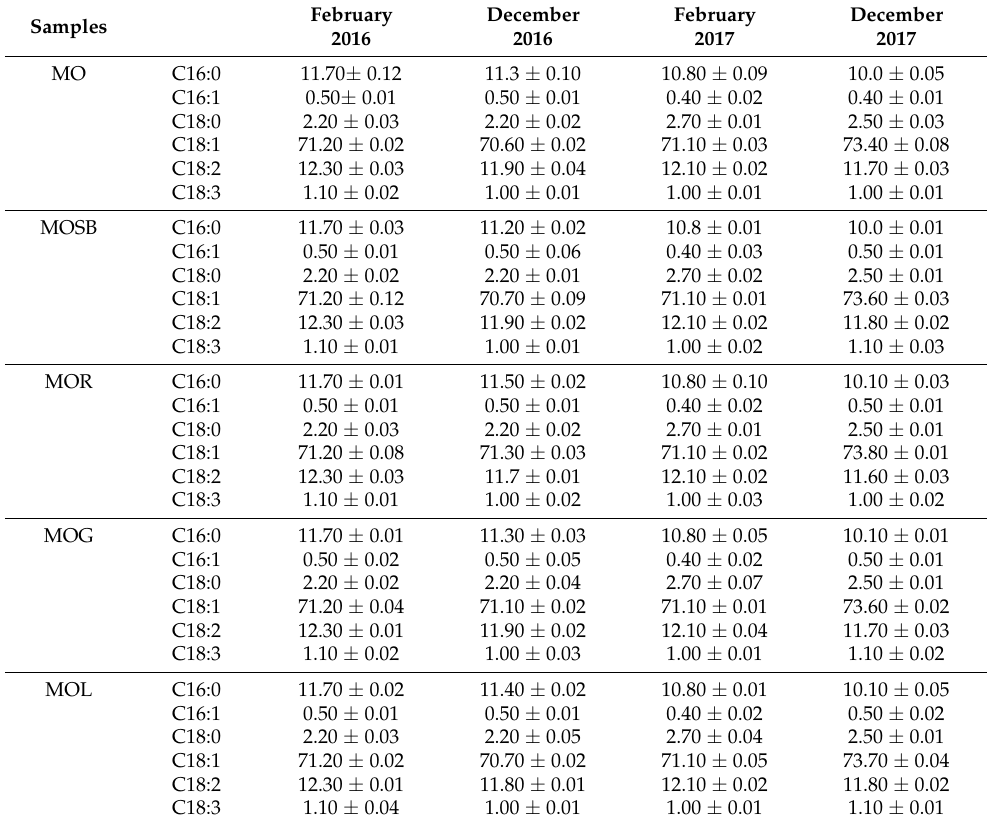
Table 5. Most representative fatty acids (%) of all olive